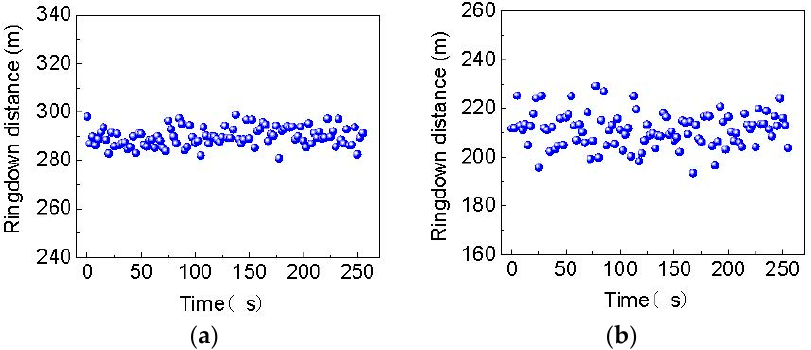
Figure 7. The stability curve of the strain sensing system with relative strain of 2 m ε loaded for ( a ) the sensing point 1 and ( b ) the sensing point 2.